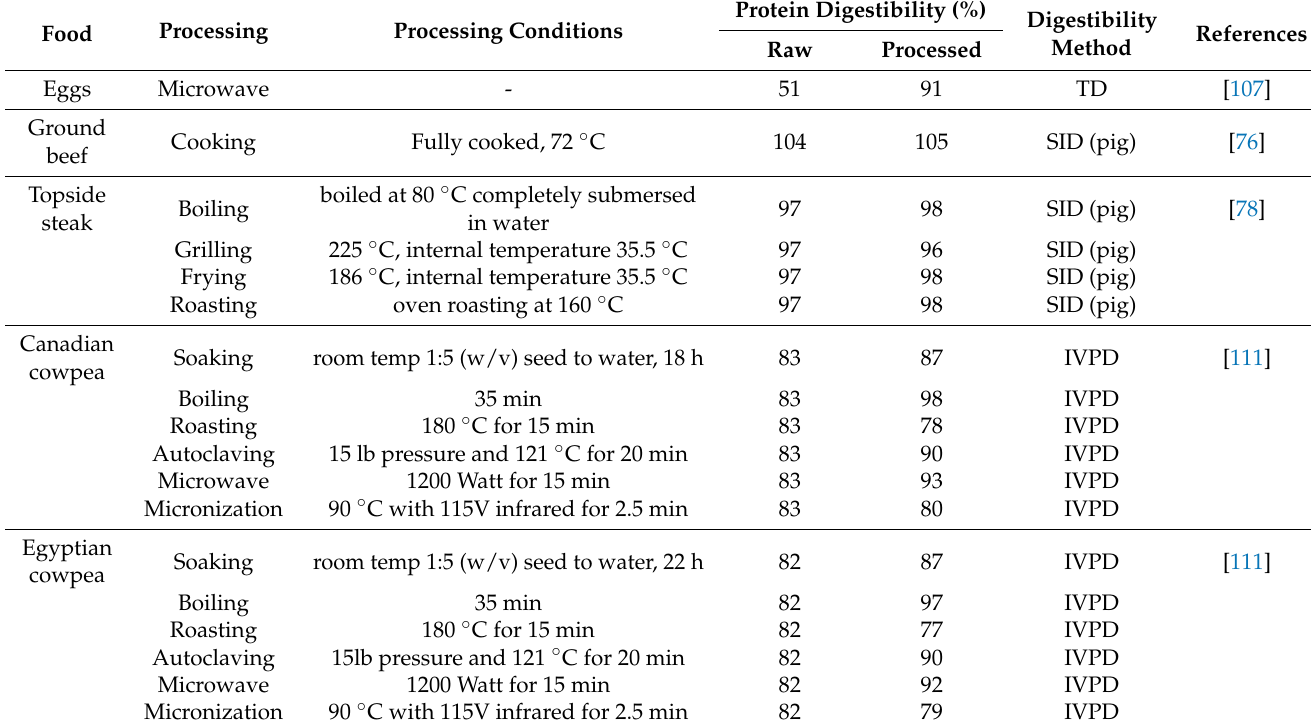
Table 6. Overview of the effects of food processing on protein